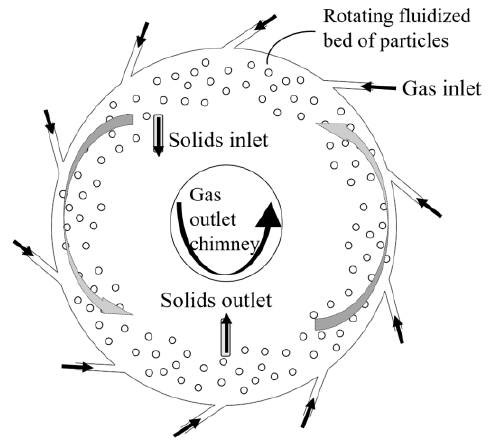
Figure 1. Schematic representation of vortex